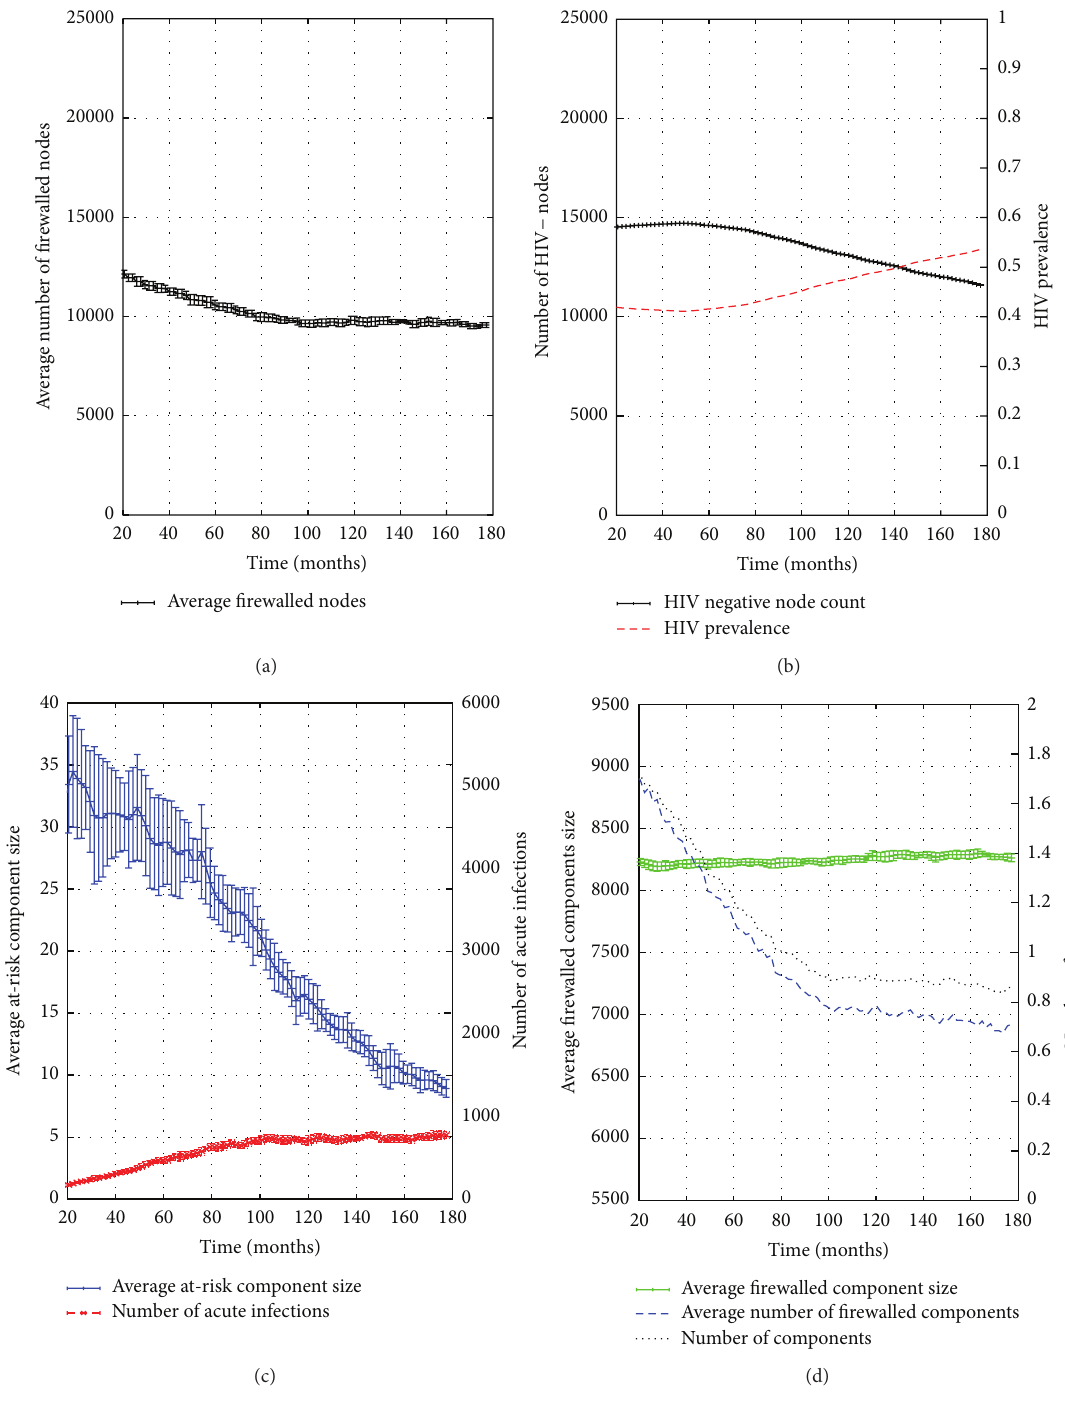
Figure 9: The firewall effect during the steady